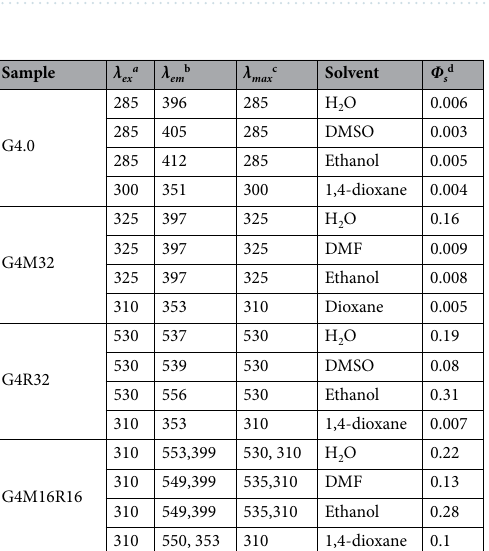
Figure 3. Solution of G4.0, G4M32, G4R32, and G4M16R16 in DMF, Ethanol, DMSO, H 2 O, and 1,4-dioxane.